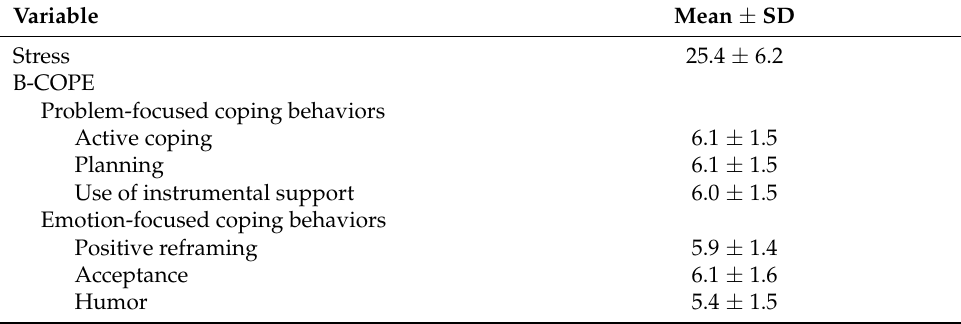
Table 2. Perceived stress, and coping behavior among critical care nurses caring for critical patients with COVID-19 ( n =